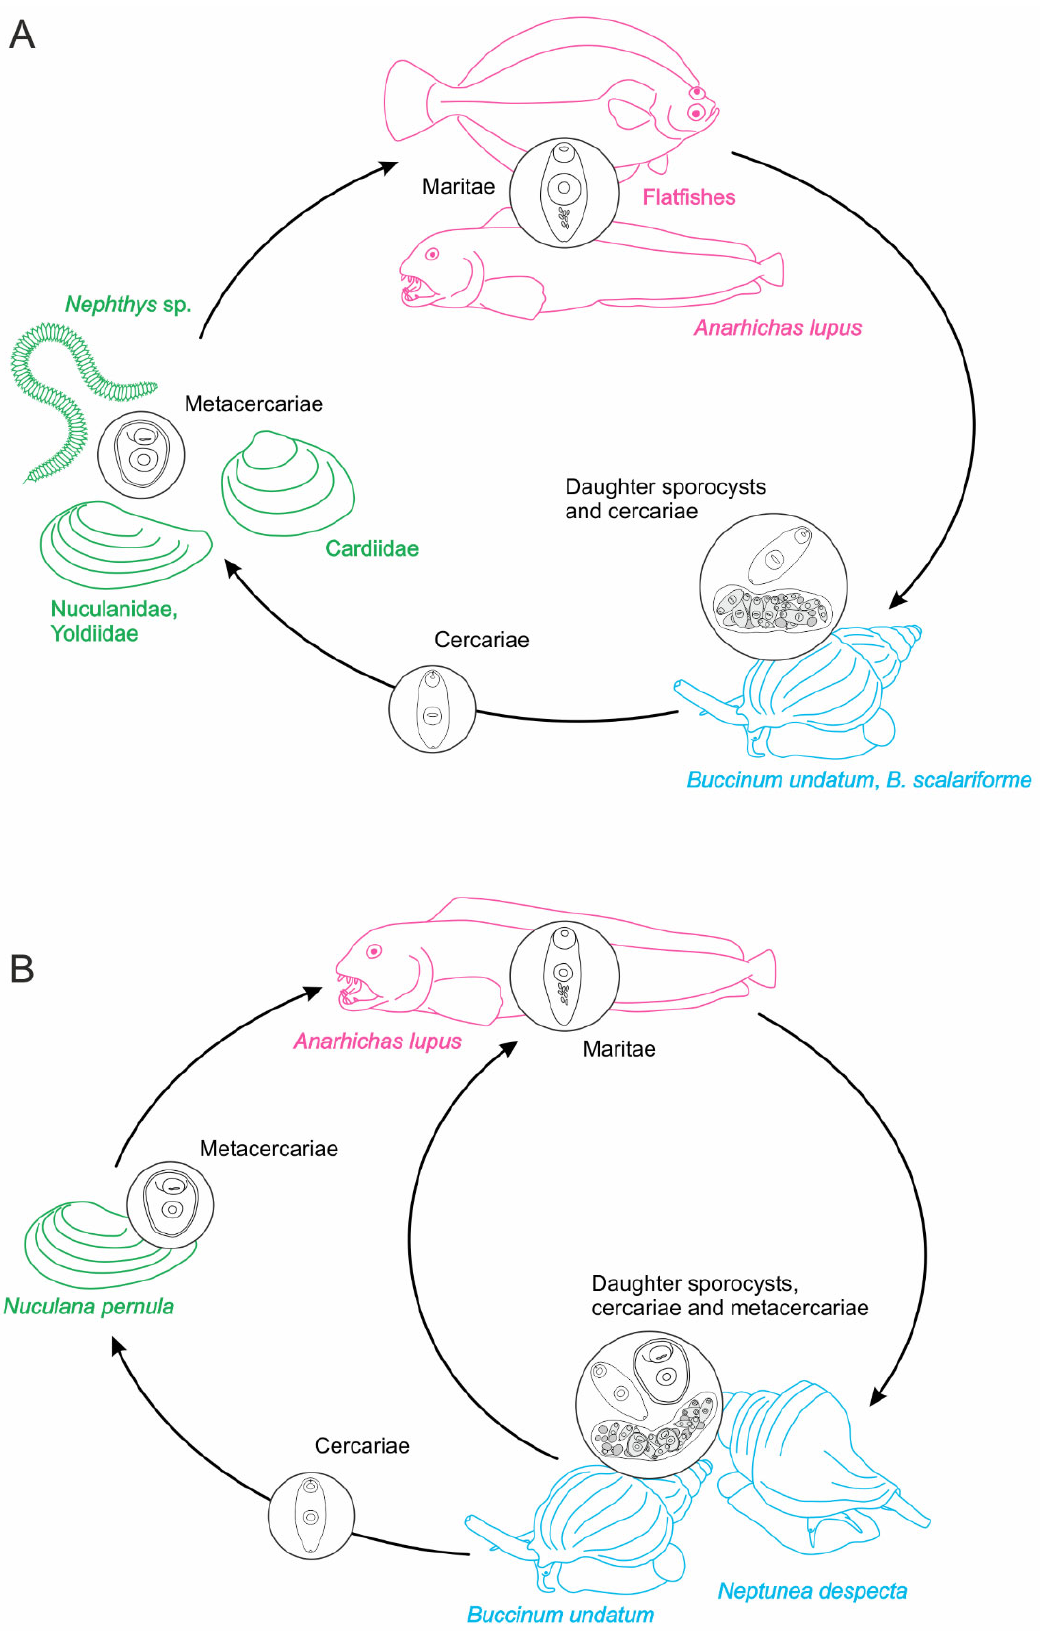
Figure 7. Life cycle schemes of Zoogonoides viviparus ( A ) and Pseudozoogonoides subaequiporus ( B ) based on the data retrieved at the White Sea.